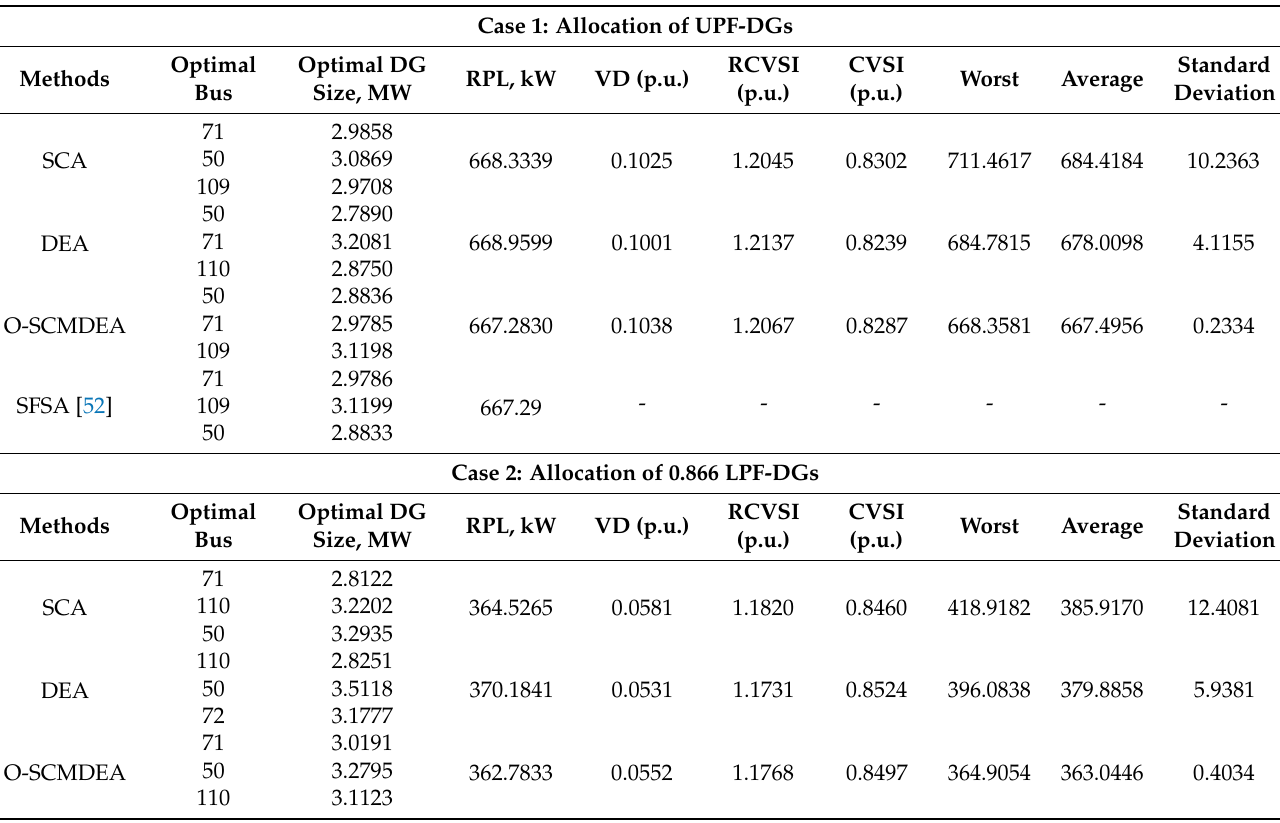
Table 8. Comparison of the results for the real power loss minimization of 118 bus